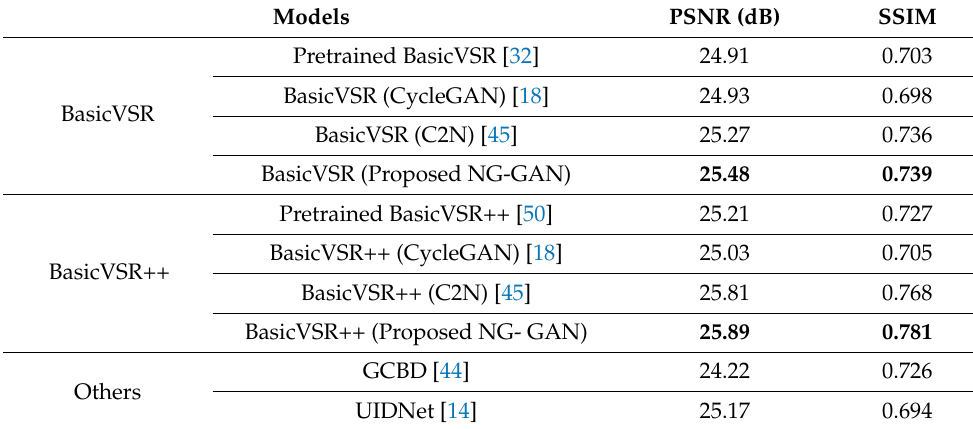
Table 1. Comparison of old noisy images denoised by state-of-the-art denoisers and image restorers trained on the dataset generated by our proposed model.